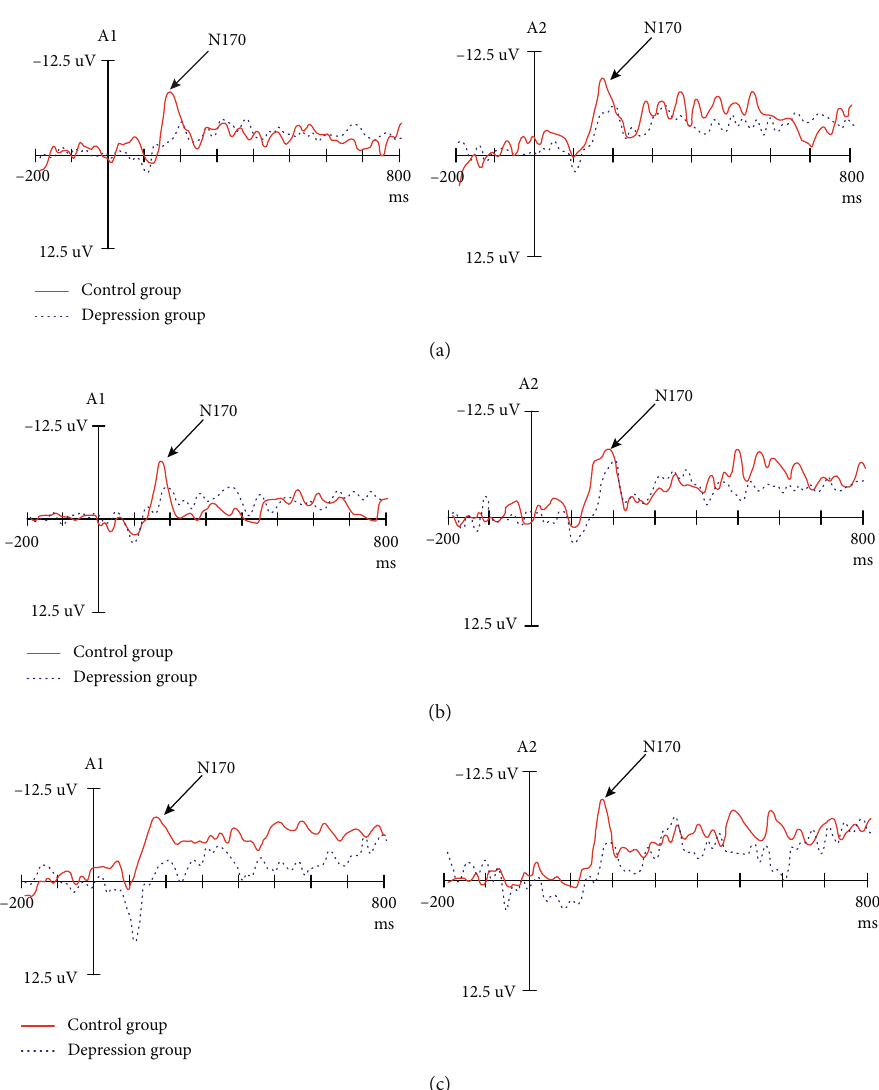
Figure 3: The amplitude and latency of facial expression ((a) happy face, (b) neutral face, and (c) sad face) between the depressed and control